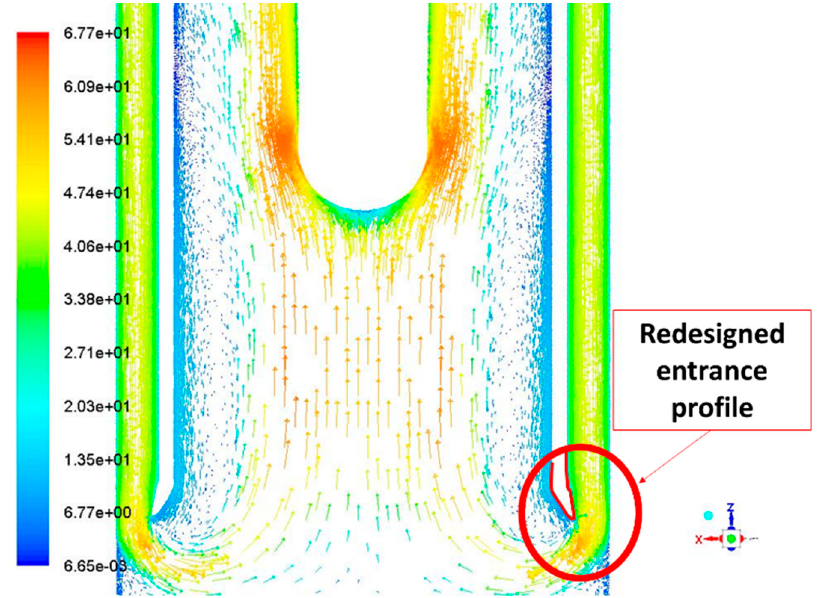
Figure 11. Redesigned entrance profile (velocity vector shown there are negligible improvements in terms of recirculation zones reduction).